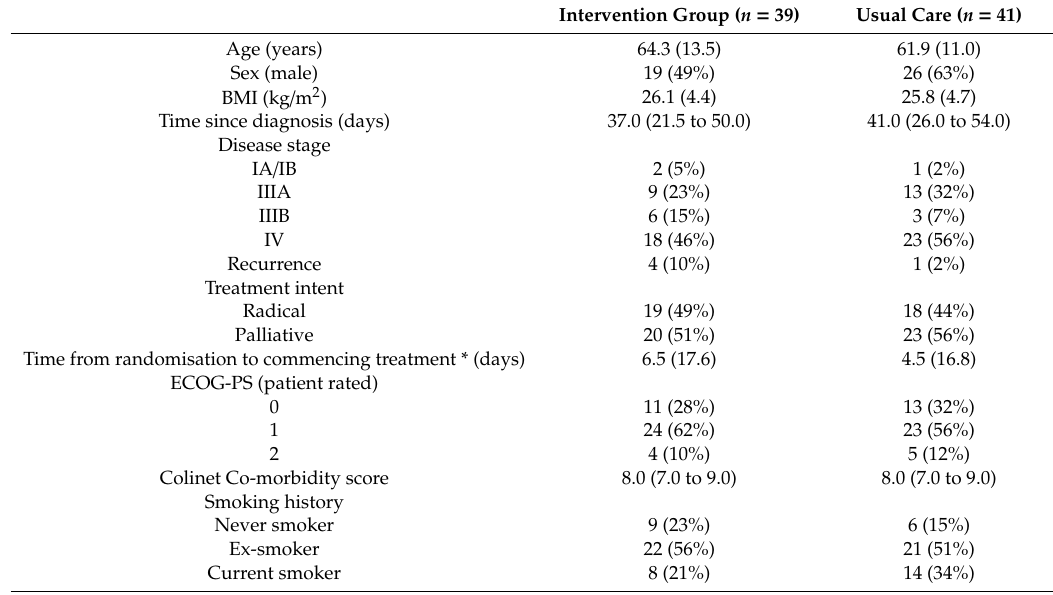
Table 1. Characteristics of participants with valid baseline physical activity data.